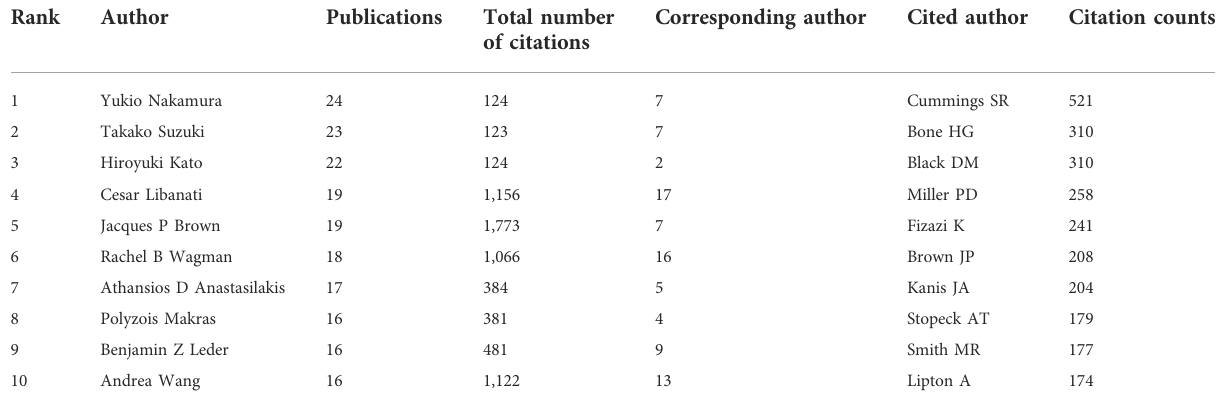
TABLE 3 Top 10 authors in terms of publication volume and the top 10 most-cited